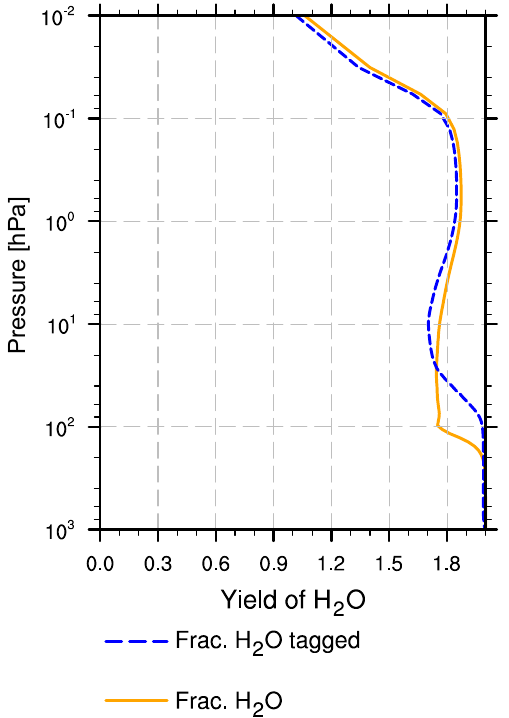
Figure 14. Comparison of all approaches determining the H 2 O yield: effective yield by box model simulations with variable OH (purple, dashed) and fixed OH (green, dash dotted), effective yield by global model simulations (red, dotted), H portion of total (yel- low, solid) and tagged (blue, long dashed) H 2 O with respect to the hydrogen